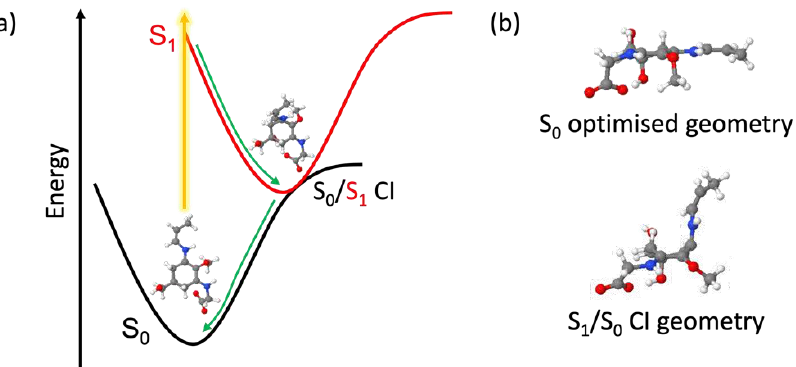
Figure 6. ( a ) Schematic of the dominant relaxation pathway of usujirene with the state-averaged CASSCF/6-31G* optimised S 0 and S 1 /S 0 CI geometries. ( b ) The geometries of usujirene in the optimised S 0 state and at the S 1 /S 0 CI with the ring along the plane.